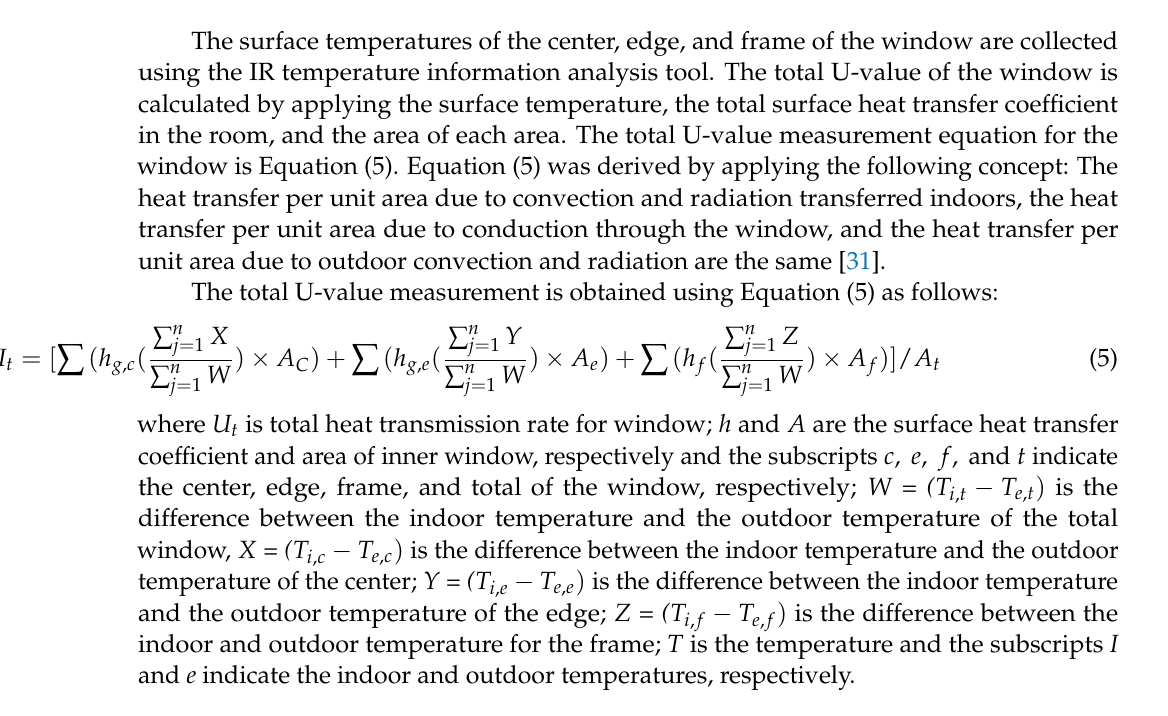
Figure 4. Window measurements using the infrared (IR) method. Table 4. Measurement cases using the IR method.